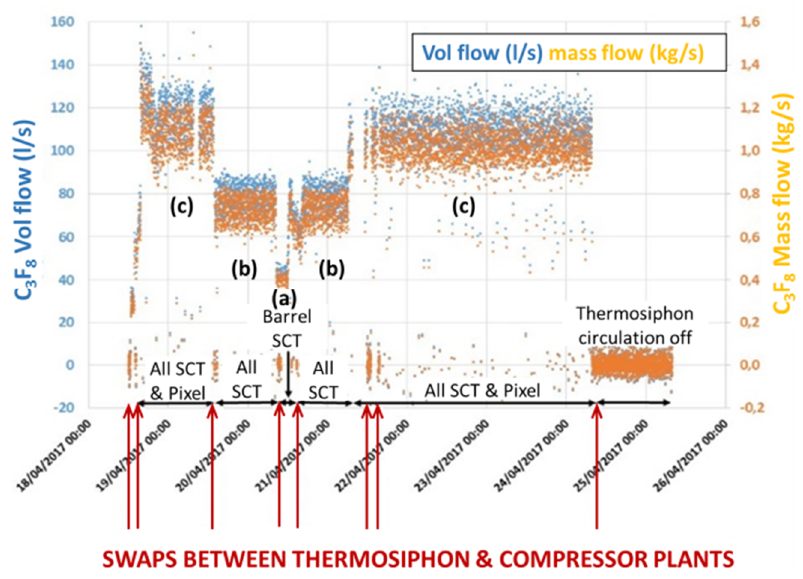
Figure 10. C 3 F 8 volumetric flow and mass flow measured ultrasonically in the vapor return line of the ATLAS TS under different load conditions ( a – c ): see text.